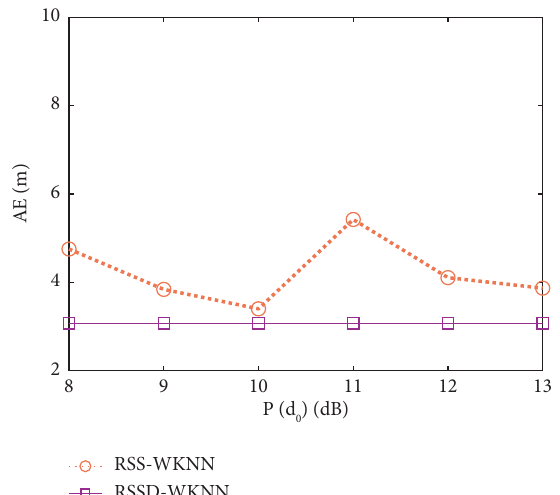
Figure 3: AE comparisons between RSS-WKNN and RSSD-WKNN under diferent P ( d